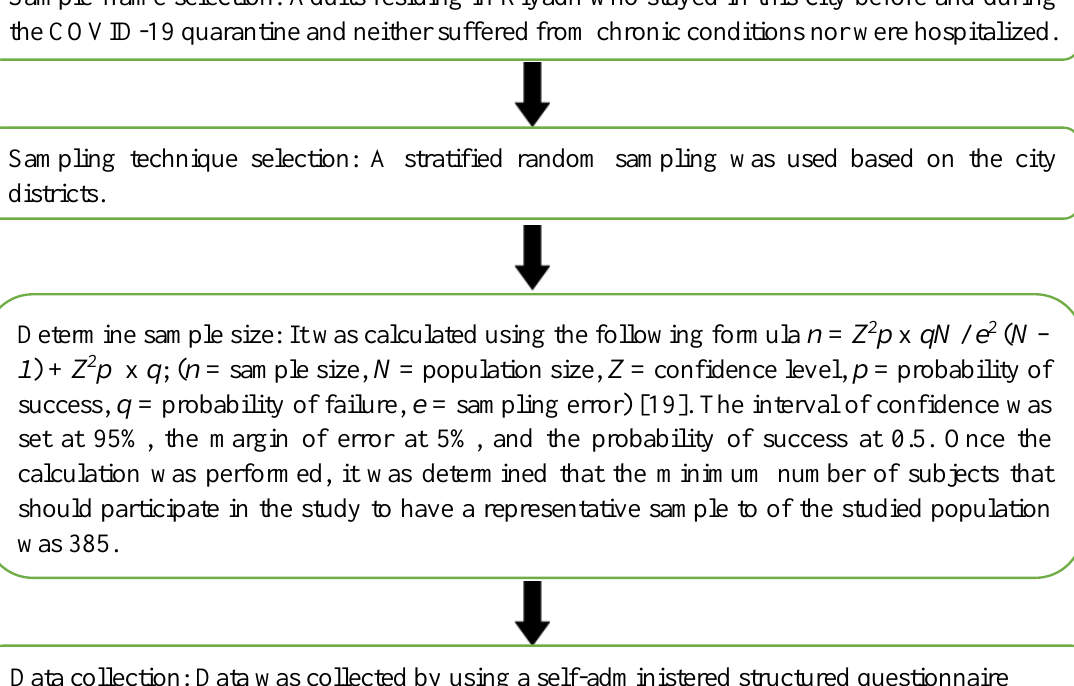
Figure 1. Sampling process steps.